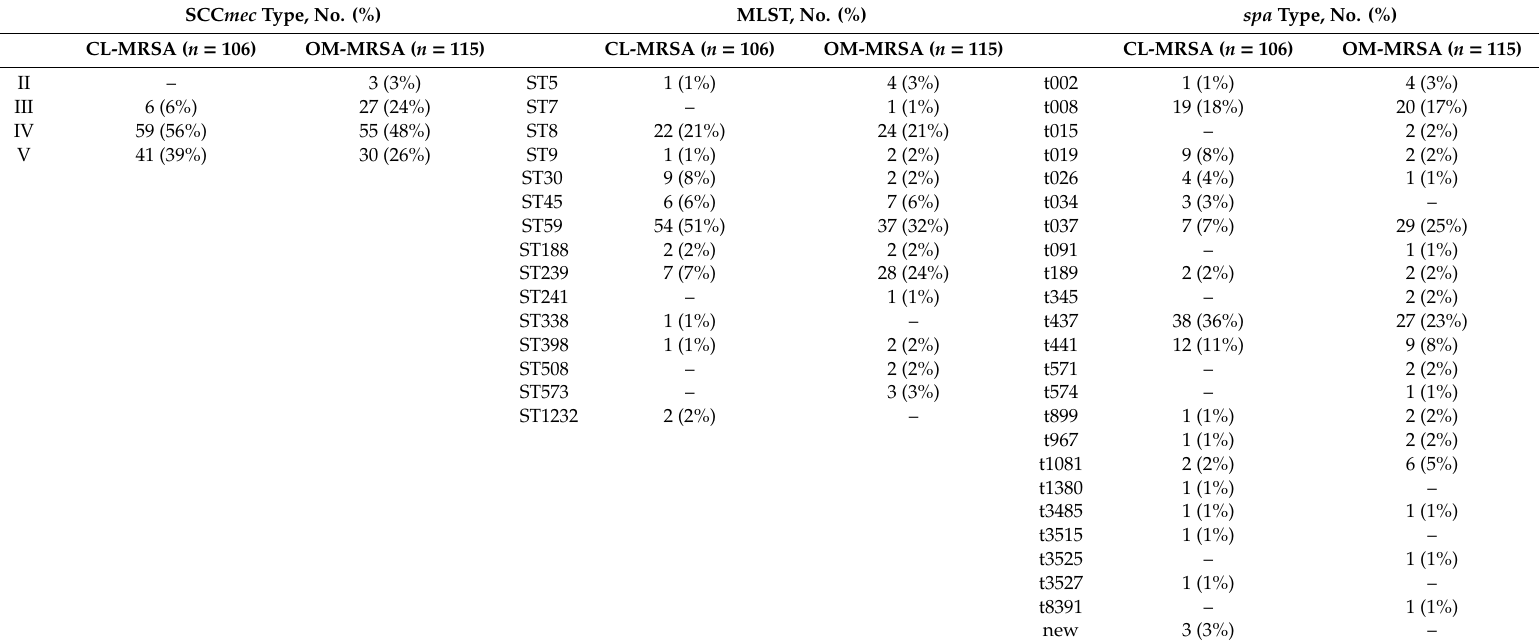
Table 3. Molecular genotyping of the isolated CL-MRSA and OM-MRSA